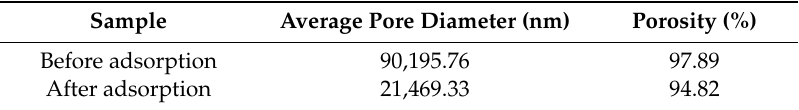
Table 8. Mercury intrusion porosimetry ( MIP) parameters of CMC/P (NIPAM-co-AA) hydrogel before and after U(VI)-loading.